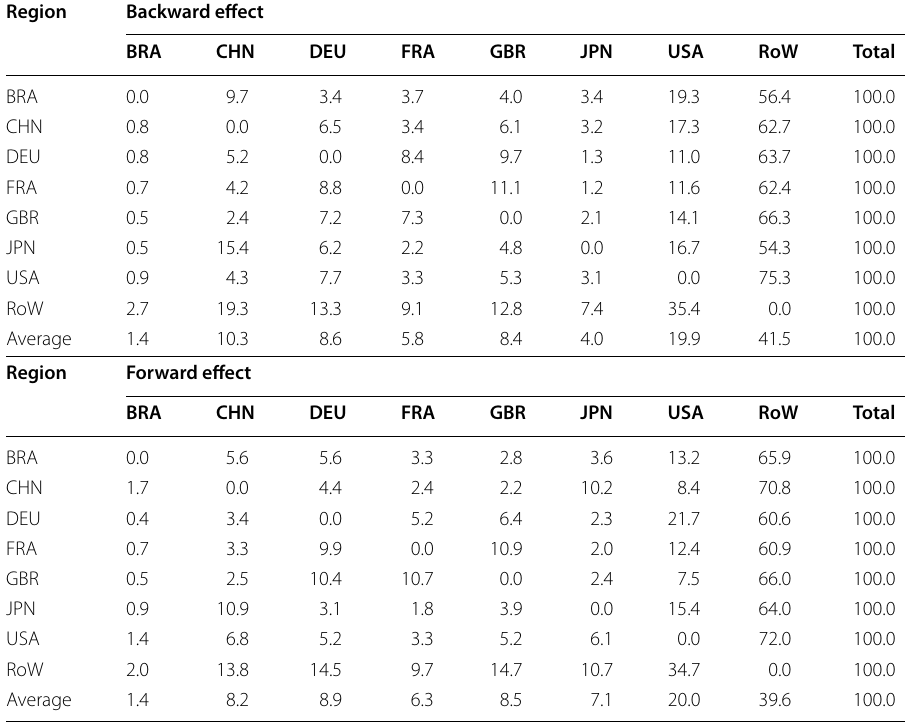
Source: research